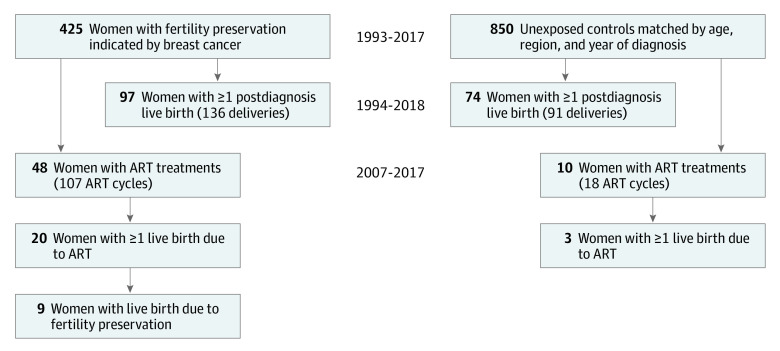
Study DiagramART indicates assisted reproductive technologies.